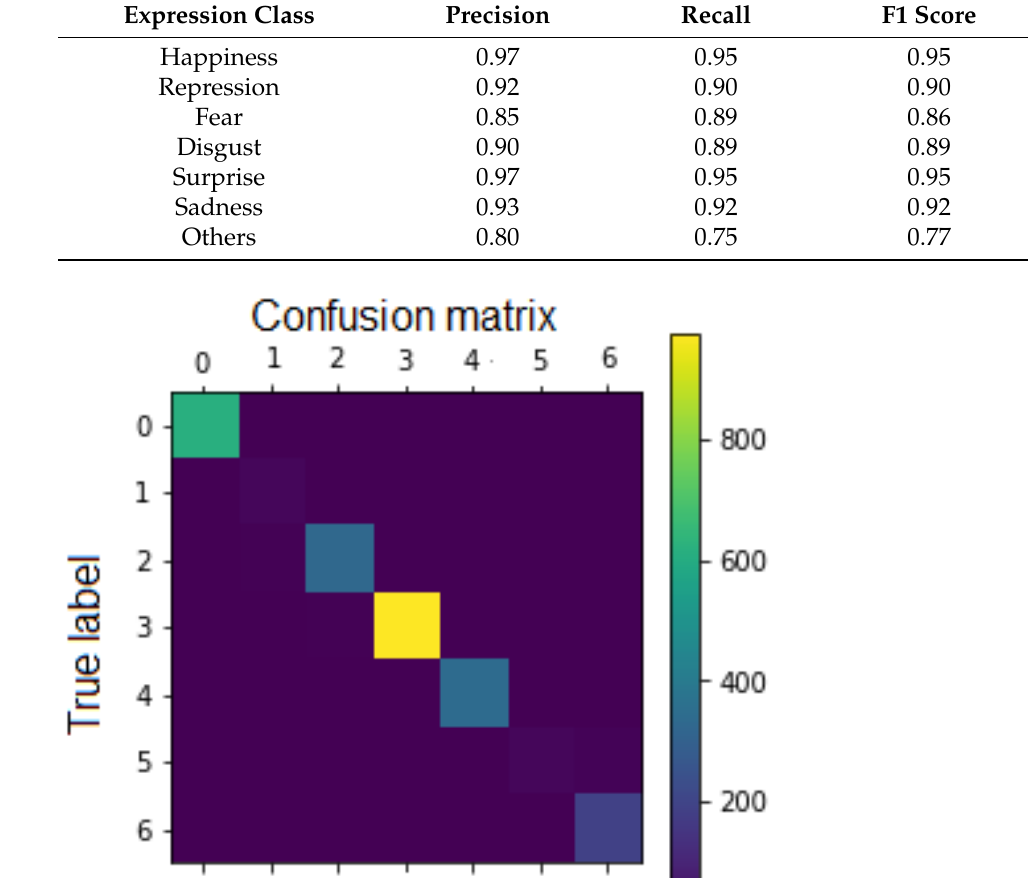
Table 4. F1 score of LARNet performance on call 7 classes.